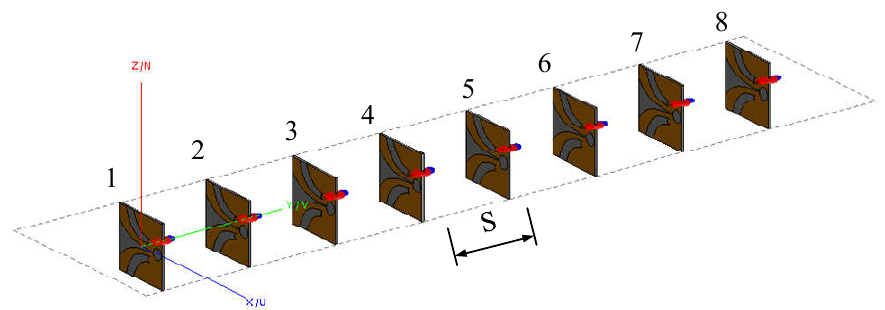
Figure 8. Vivaldi antenna model.